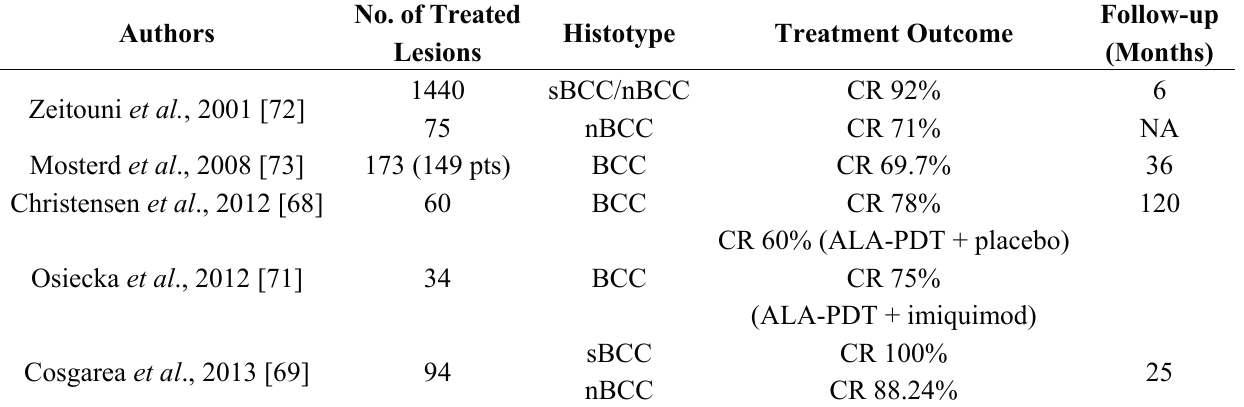
Table 1. Clinical results of ALA-PDT in treatment of